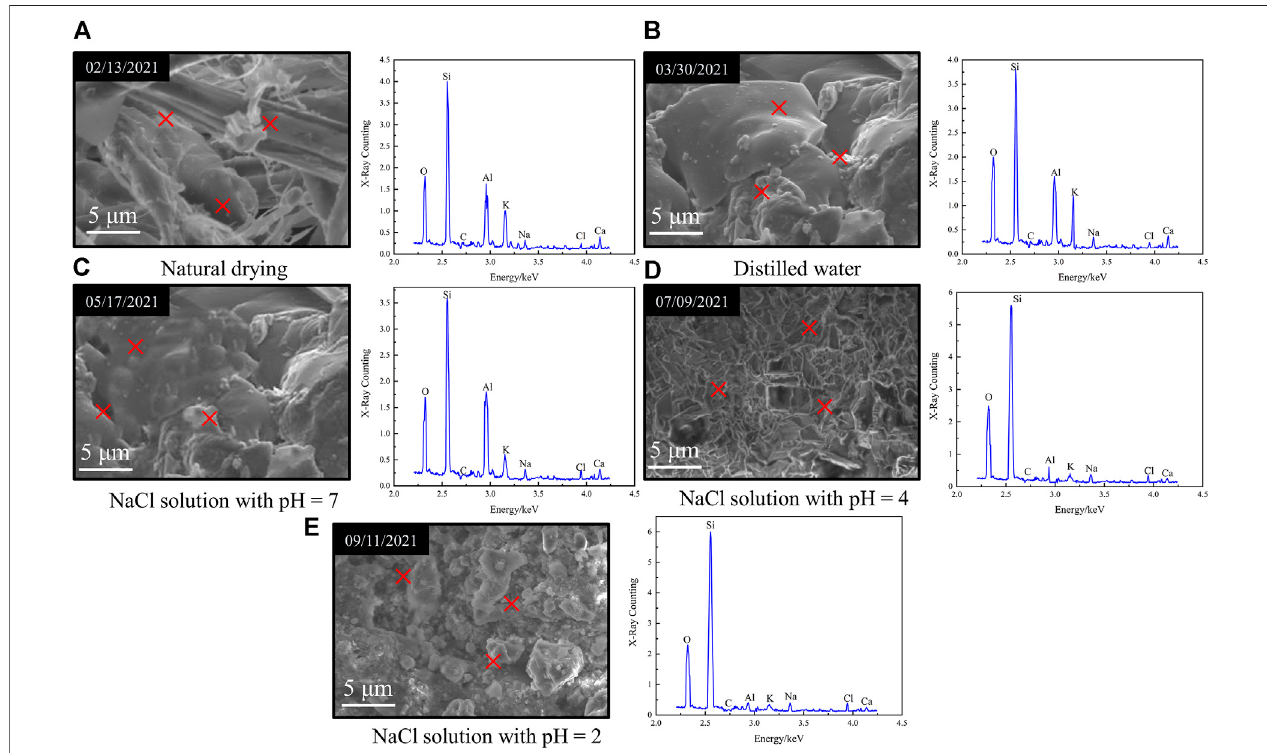
FIGURE 5 | Energy dispersive spectroscopy analysis of granite under the fl ow rate of v = 150 mm · s − 1 with different aqueous chemical solutions for 49 days. (A) Natural drying. (B) Distilled water. (C) NaCl solution with pH=7. (D) NaCl solution with pH=4. (E) NaCl solution with pH=2